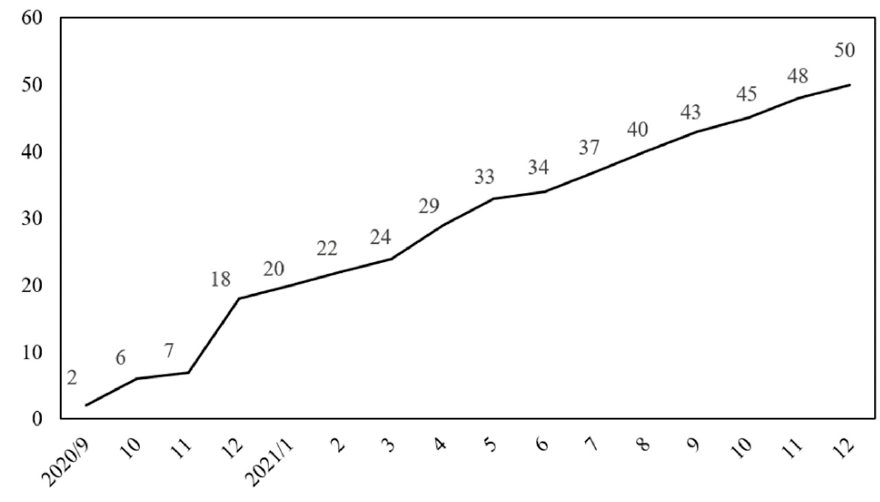
Figure 12. The trend in the cumulative number of luxury brands joining Amazon.